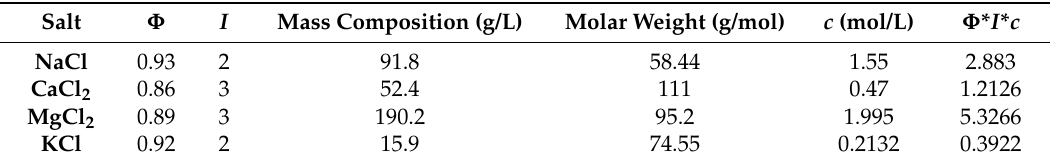
Table 1. Dead Sea salt composition